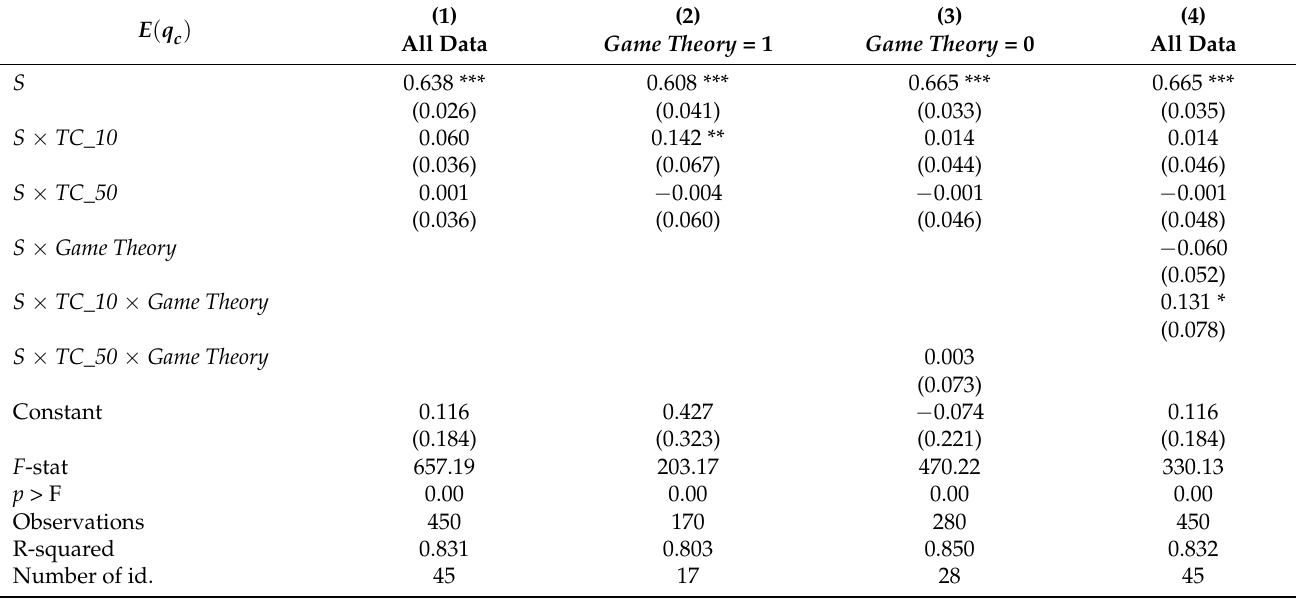
Table 5. Trustee’s expectations of the “corruption tax” (third agent’s